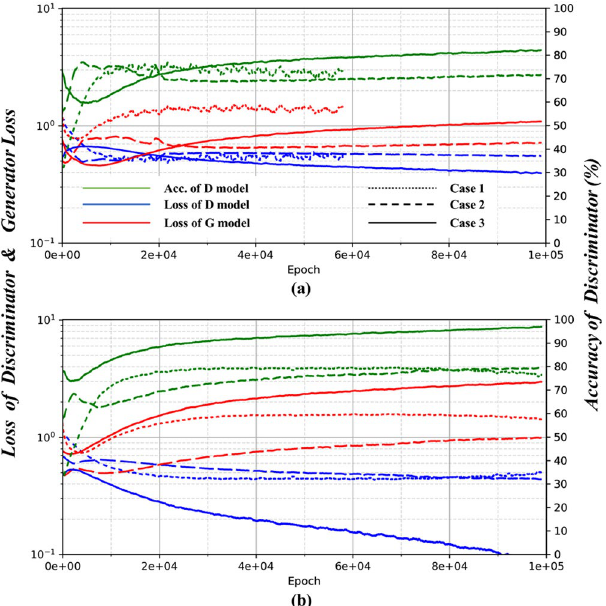
Figure 6. The change of loss values of the generator ( G model) and the discriminator ( D model) and accuracy of the discriminator over epochs for ( a ) Subcase 1 (Case 1-1, Case 2-1, Case 3-1), ( b ) Subcase 2 (Case 1-2,